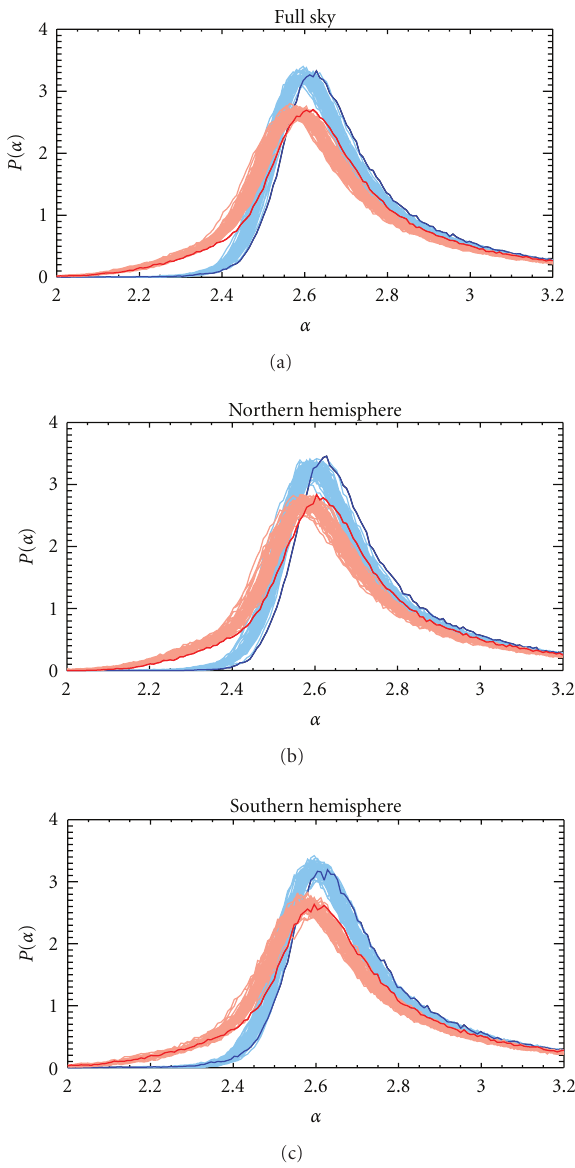
Figure 7: The probability densities P ( α ) of the scaling indices for the WMAP 5-year data (dark lines) and for 50 simulations (fainter lines) by using the scale parameter r = 0 . 2 and the KQ75-mask, computed for the original (red) and the mask-filling method (blue). The upper histogram shows the distribution of the full-sky data set, while the middle and the lower ones show the distribution of the northern and southern hemispheres,